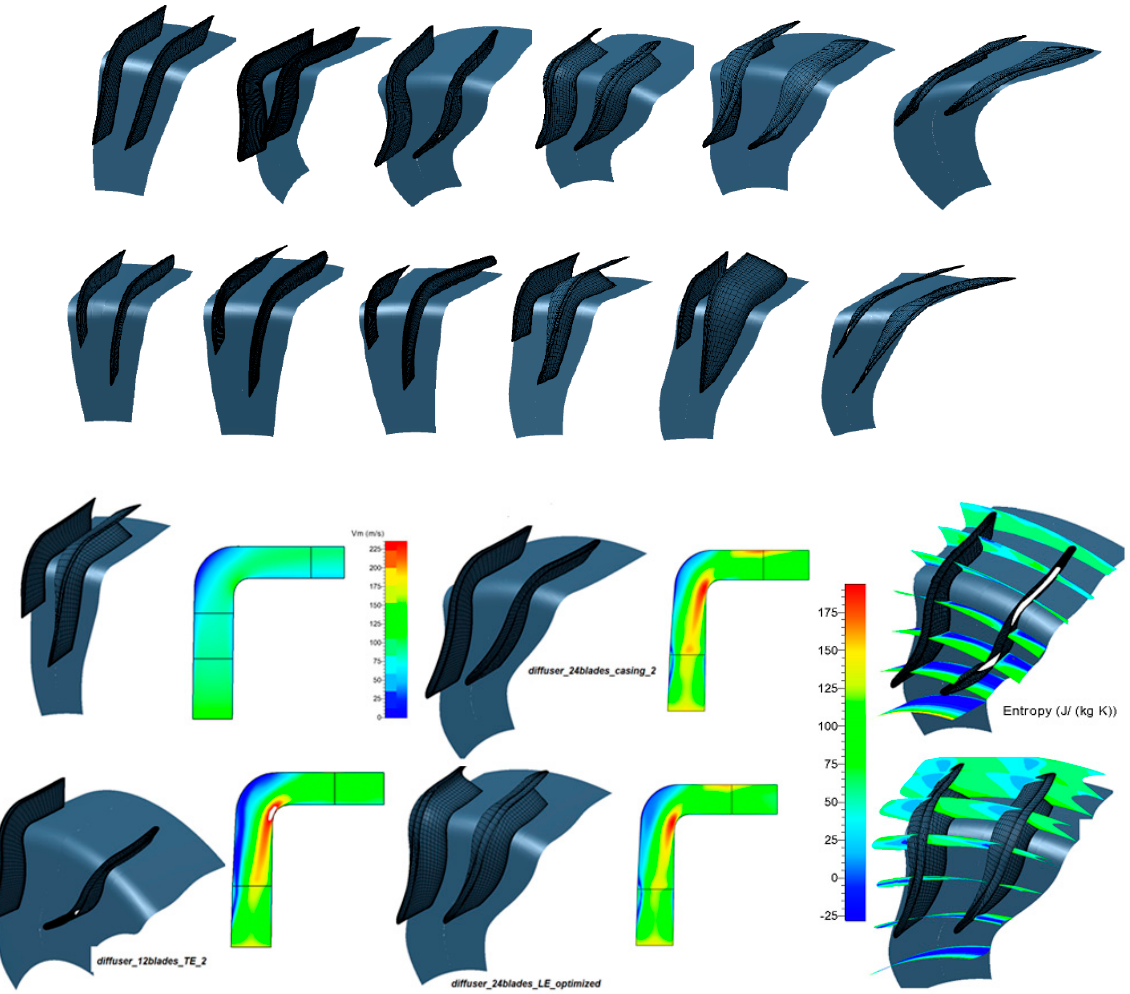
Figure 29. Several optimums with and without splitters. V m and entropy contours for both versions.